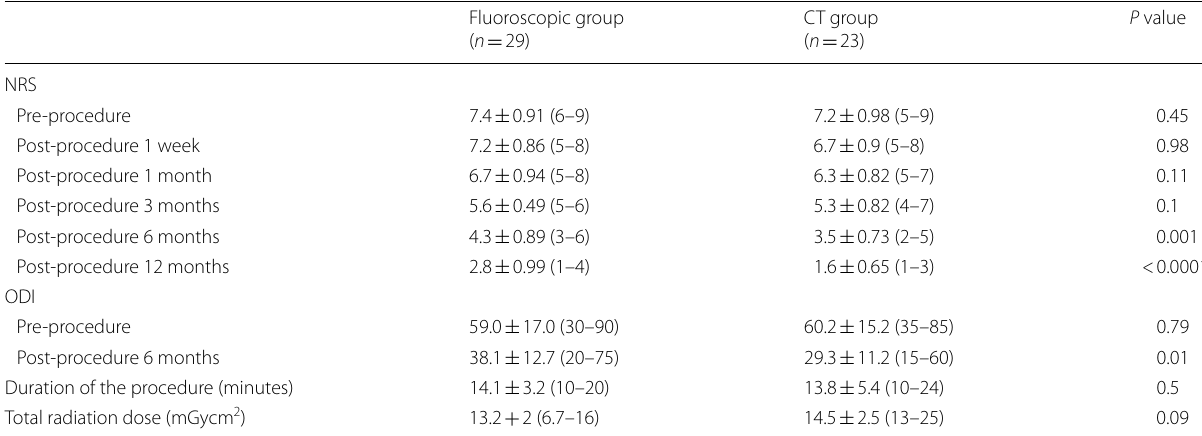
Table 2 Comparison of outcome measures between the two groups